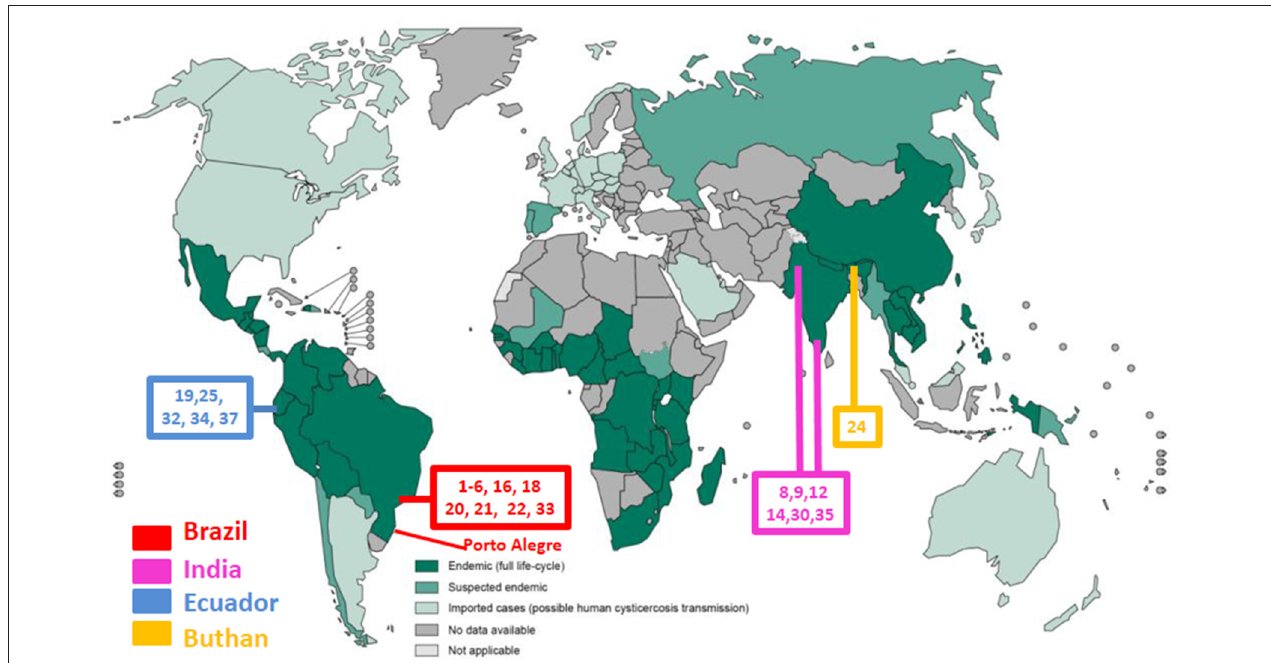
FIGURE 4 | The map is showing countries at risk for neurocysticercosis in the world, according to World Health Organization (/WHO). at:http://apps.who.int/iris/ bitstream/10665/153237/1/9789241508452_eng.pdf?ua = 1. [Last accessed November, 2021]. The map is also showing places were main of the original clinical work evaluating the association of neurocysticercosis and mesial temporal lobe epilepsy associates with hippocamapal sclerosis were done. Numbers are references to these works, as detailed in Table 6